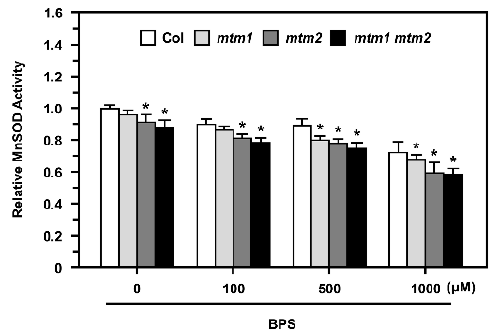
Figure 7. MnSOD activity of Col, mtm1 , mtm2 , and mtm1 mtm2 -double mutant protoplasts after Fe 2+ - specific chelator (BPS) treatment. Protoplasts were treated without or with 100, 500, or 1000 μM BPS for 16 h. MnSOD activity in protoplasts was measured relative to Col without BPS treatment. Data are mean ± SD of three independent repeats. * Significant at p < 0.05 compared with the Col.